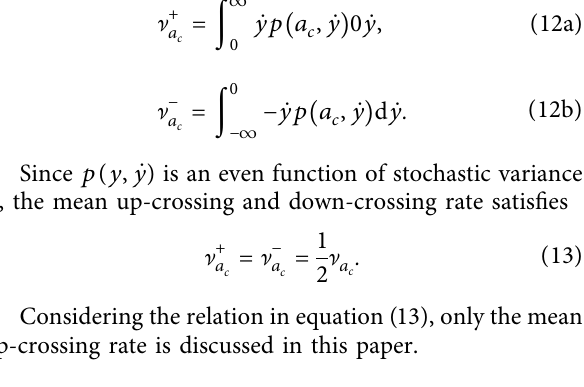
a c vs. critical value of excursion